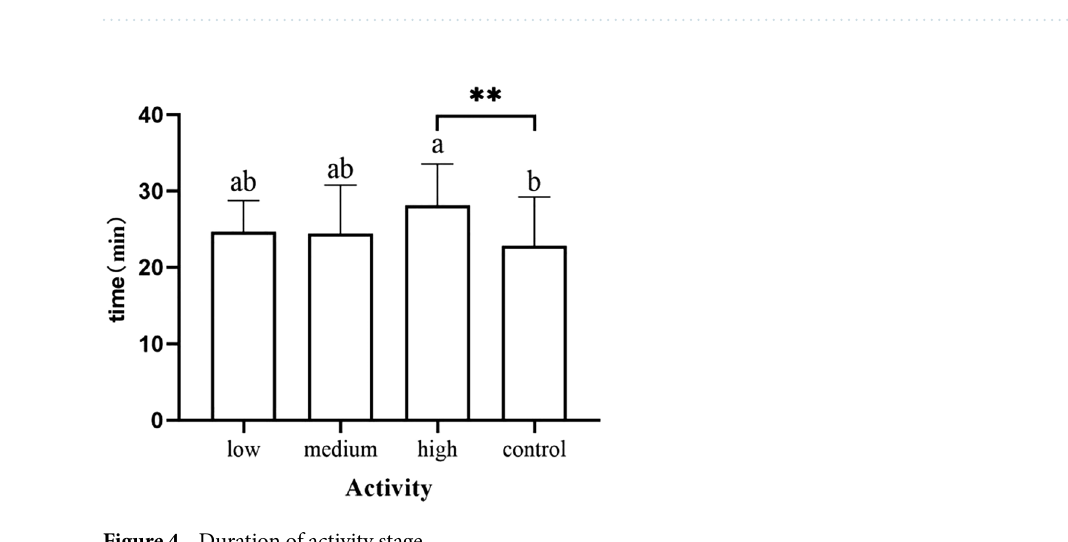
Figure 3. Occurrence time of eating hands.